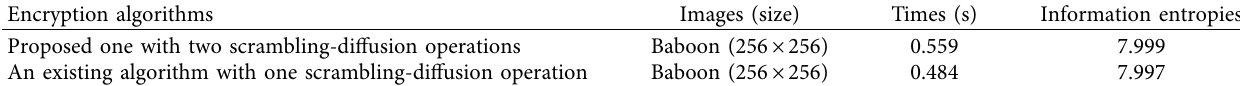
Table 7: Encryption times and information entropies of the encrypted images. Encryption algorithms Proposed one with two scrambling-diffusion